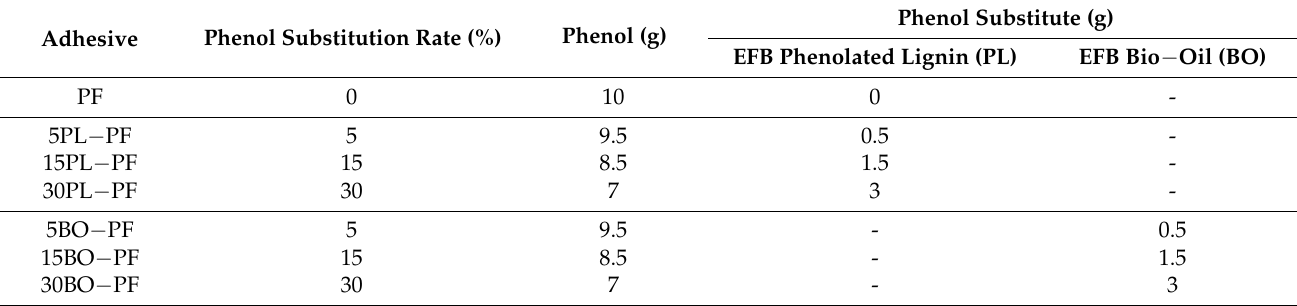
Table 1. The variation of phenol substitute and the substitution